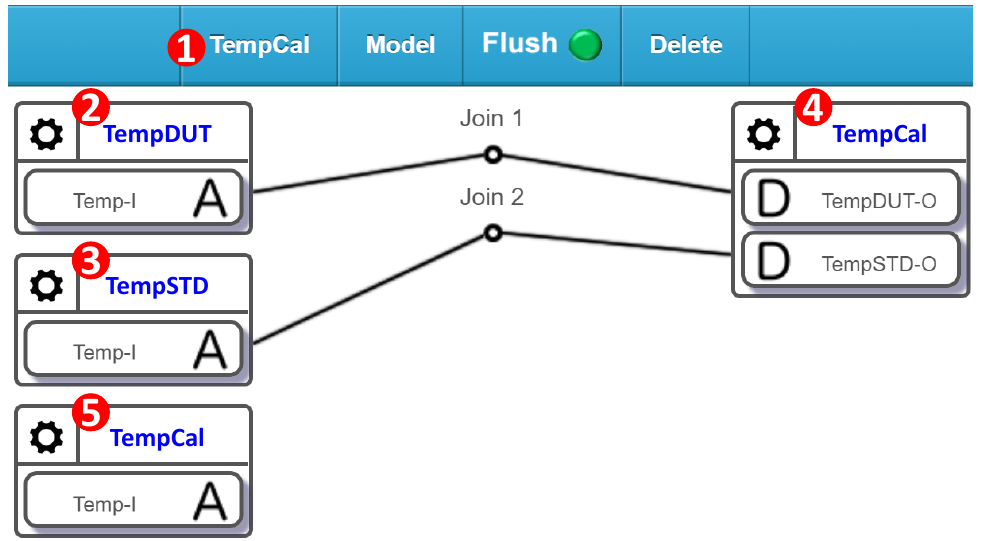
Figure 14. Temperature calibration.